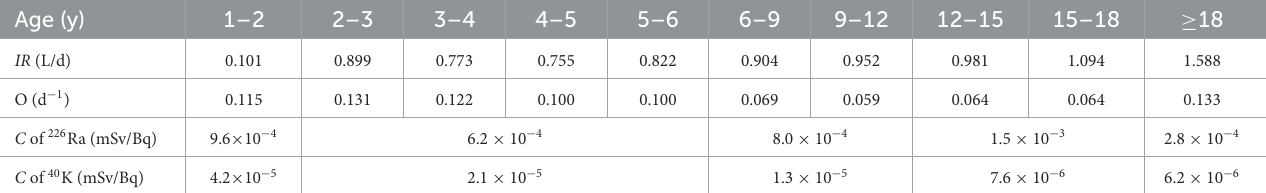
TABLE 1 The age-dependent drinking water ingestion rates, outdoor occupancy factors, and effective dose conversion